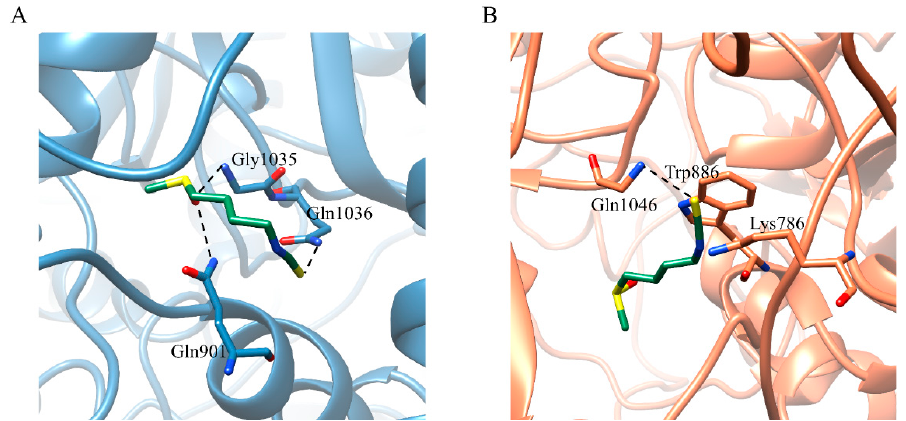
Figure 3. Detailed view of SFN binding to the ( A ) S closed and ( B ) S open . The key residues are represented by stick models, and the important H-bonding interactions are labeled in the black lines. The C atoms of S closed and S open are colored in blue and coral, respectively. The O, N, S atoms are colored in red, blue and yellow, respectively.